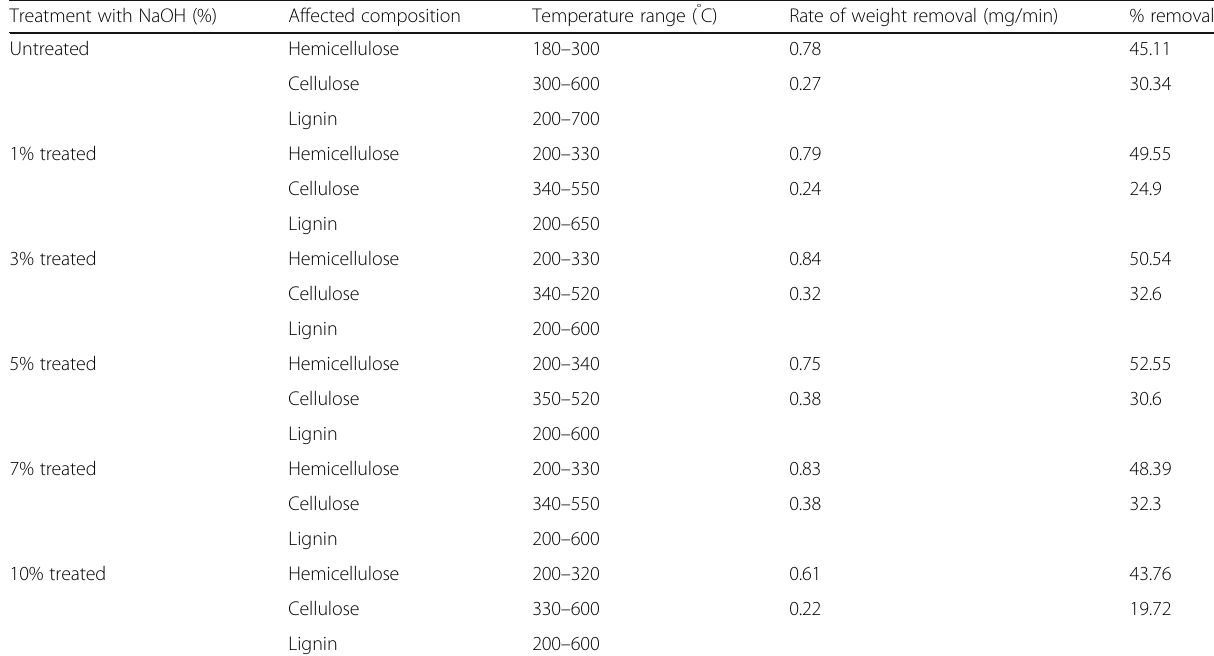
Table 4 Rate of weight loss of rice straw Treatment with NaOH (%) Affected composition Temperature range ( ° C) Rate of weight removal (mg/min)